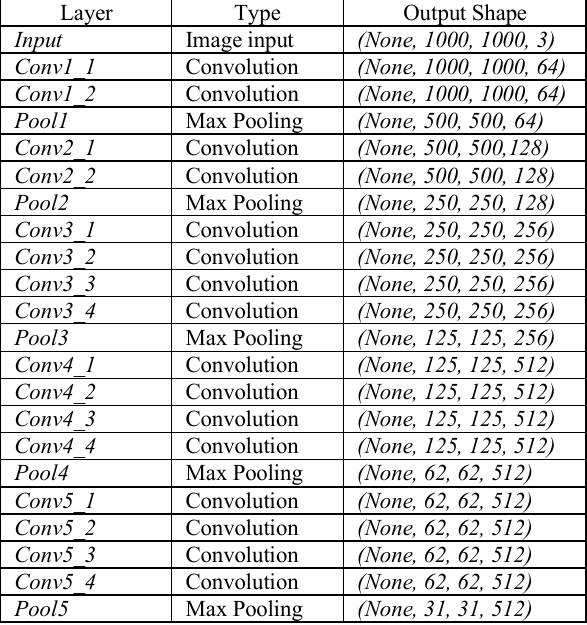
Table 1. The convolutional blocks of VGG19, taking an input image with a size of 1000 × 1000 × 3 as an example to calculate the output shape.